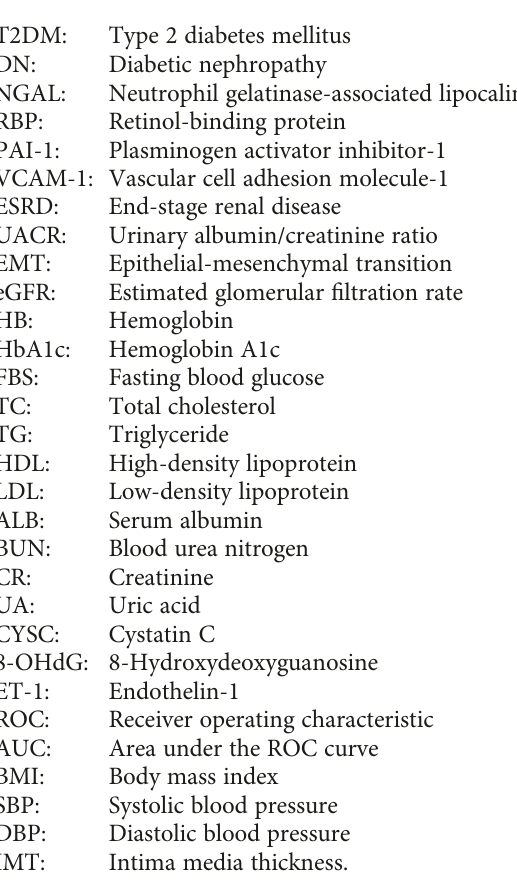
Table S1: clinical characteristics of the T2DM patients. Figure S1: associations between urinary biomarkers with UACR in T2DM patients. A: levels of urinary biomarkers in T2DM patients with/without albuminuria. B: relationship between urinary biomarkers and UACR in T2DM patients. ∗∗ p < 0 01 vs. the normoalbuminuria group. NGAL: neutrophil gelatinase-associated lipocalin; RBP: retinol-binding protein; PAI-1: plasminogen activator inhibitor-1; VCAM-1: vascular cell adhesion molecule-1. (Supplementary